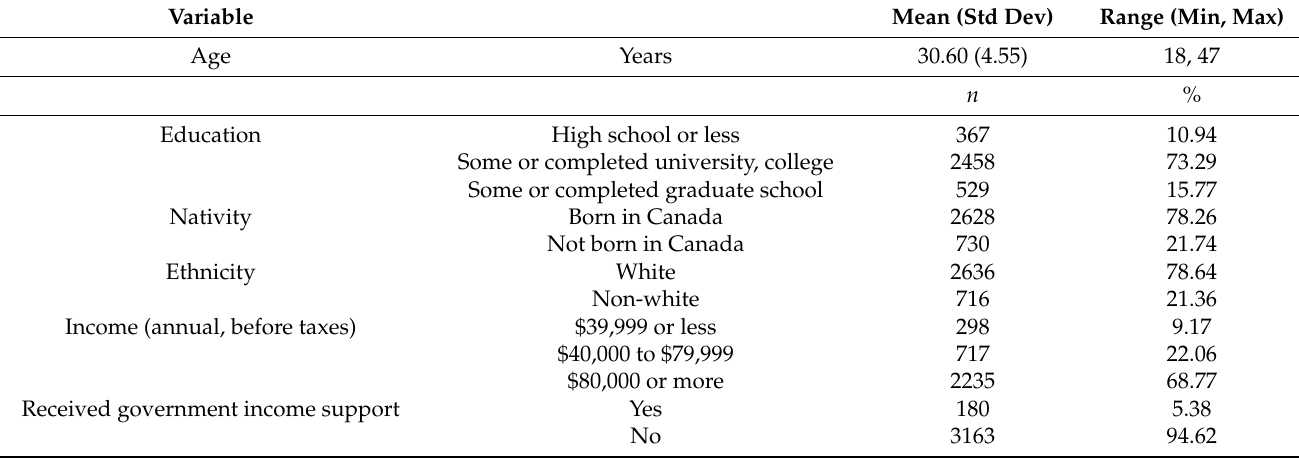
Table 1. Baseline characteristics of the